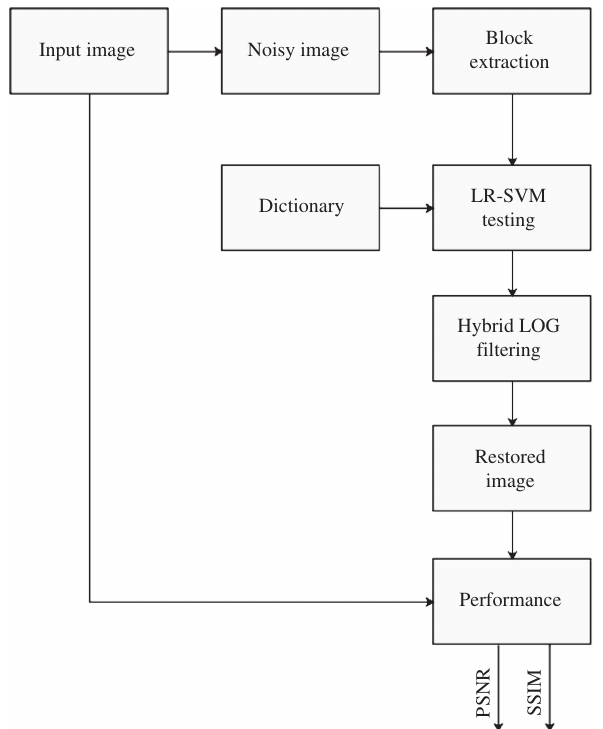
Figure 3: Block Diagram of LR-SVM